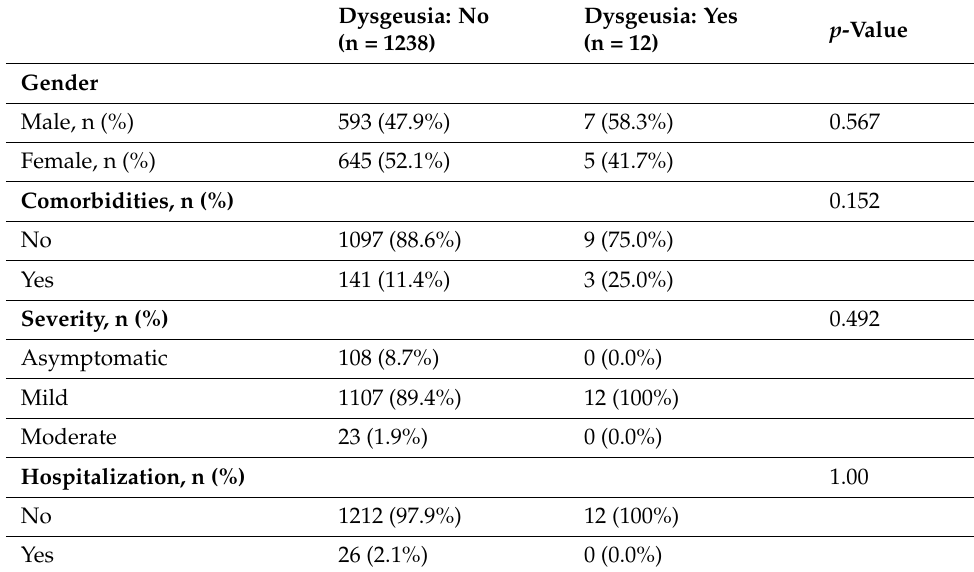
Table 4. Dysgeusia at FUP